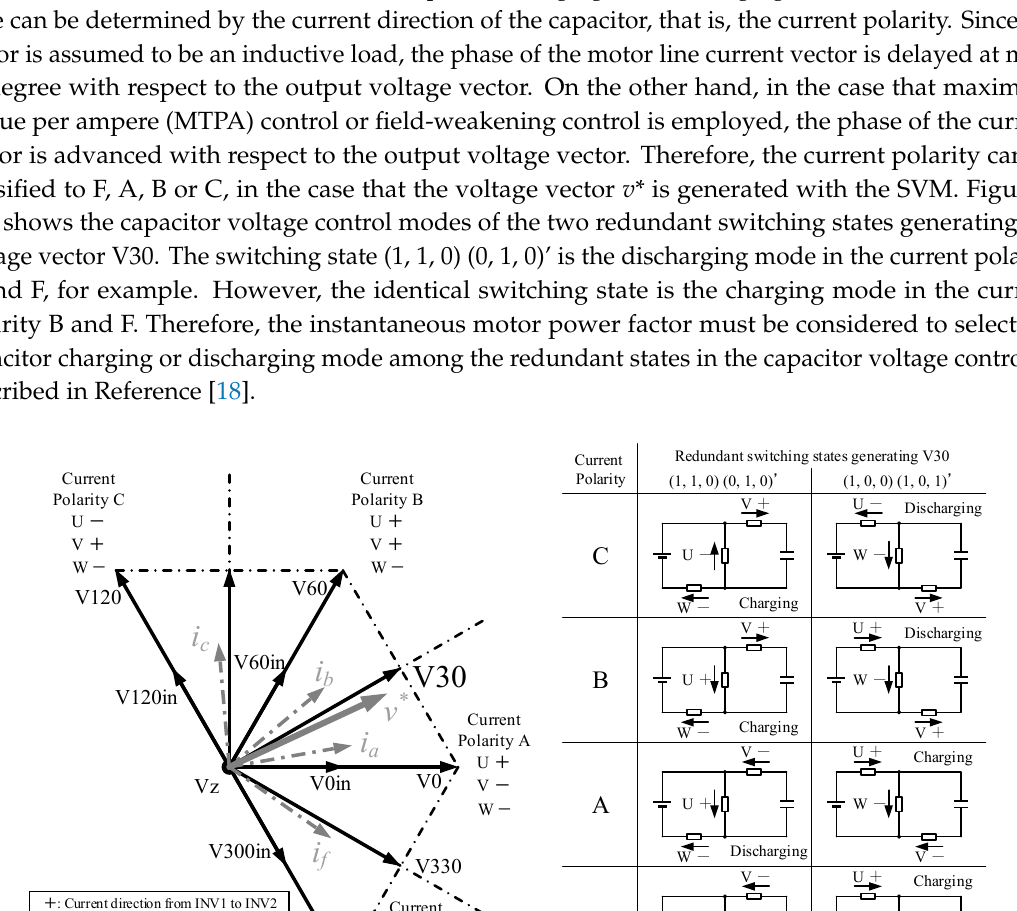
Figure 6. Impact of instantaneous motor power factor.